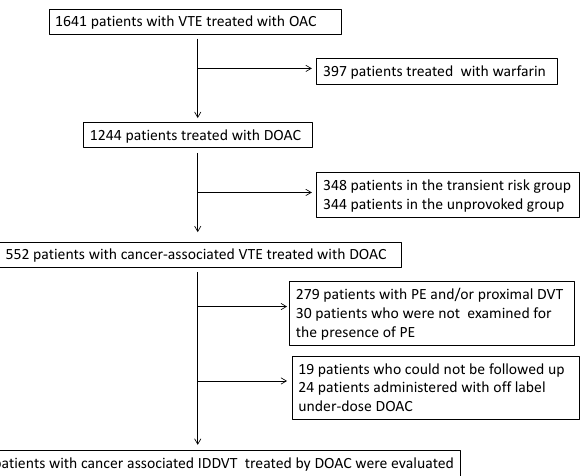
Figure 1. Flowchart of participant inclusion criteria. VTE, venous thromboembolism; OAC, oral anti- coagulant; DOAC, direct oral anticoagulant; DVT, deep vein thrombosis; PE, pulmonary embolism; IDDVT, isolated distal deep vein